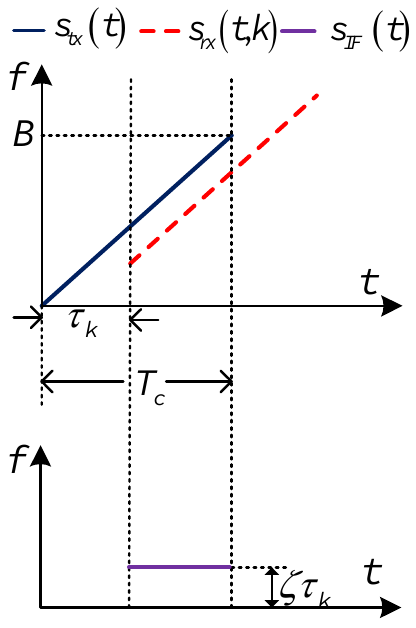
Figure 1. IF signal